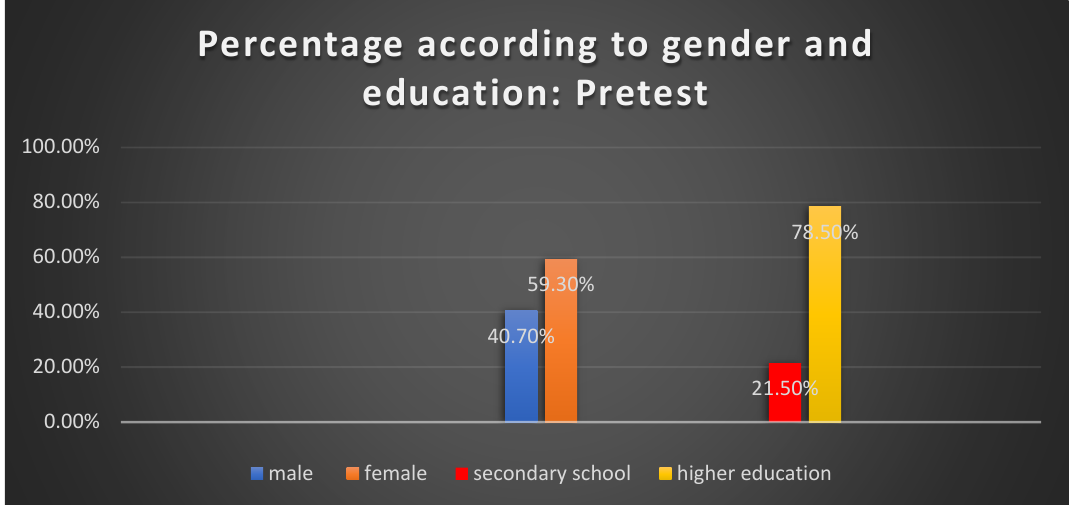
Table 9. Posttest 1 for the preposition by .